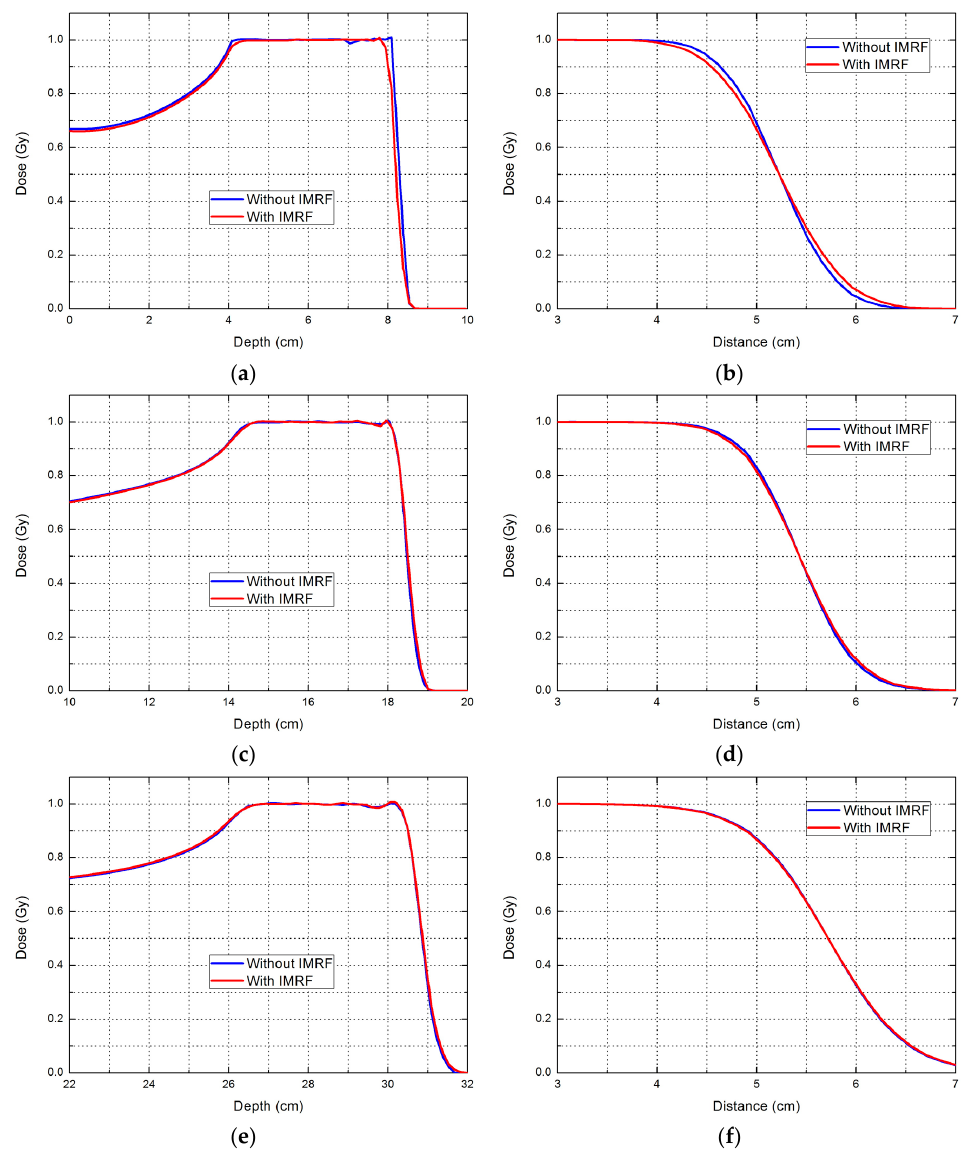
Figure 3. Spread-out Bragg peak (left column) and lateral profile (right column) for three ranges with a spread-out Bragg peak of 4 cm and a field size of 10 × 10 cm 2 . The depth of the lateral profile is selected at the middle of the spread-out Bragg peak. The range is 8 cm for ( a , b ); 18 cm for ( c , d ); and 30 cm for ( e , f ).